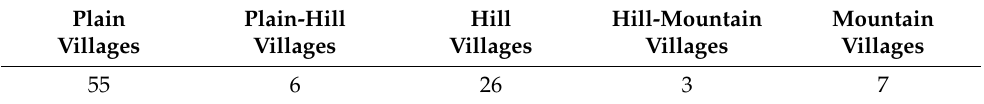
Table 1. Number of villages in the study and distribution by relief. Plain Plain-Hill Villages